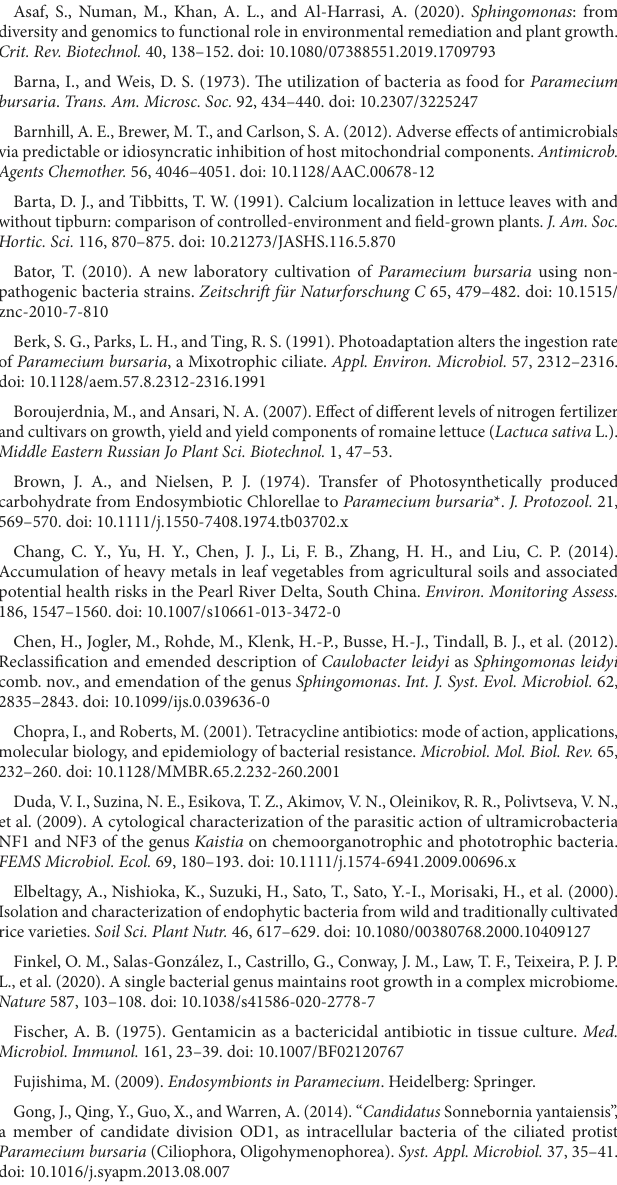
SUPPLEMENTARY TABLE S1 Differential abundance analysis of bacterial taxa detected in P. bursaria For each bacterial taxon detected in P. bursaria individuals, a Bonferroni correction was performed, and abundances were compared among eight actively proliferating (red) and six poorly proliferating (blue) P. bursaria strains using the differential abundance analysis method. The red column indicates the results of a 1:1 comparison (28 combinations in total) among the eight strains. The abundance of each bacterial colony for each combination is shown. The closer this number (p-value) is to 0, the more the abundance of the detected bacteria differ from each other. In the blue column, similar comparisons were made for combinations of six poorly growing strains (15 combinations in total). The red and blue columns are the results of a 1:1 comparison (48 possible combinations in total) between actively and poorly growing strains. SUPPLEMENTARY TABLE S2 Abundance of bacterial taxa detected in actively and poorly proliferating P. bursaria strains. The actively proliferating P. bursaria strains (eight in red) and